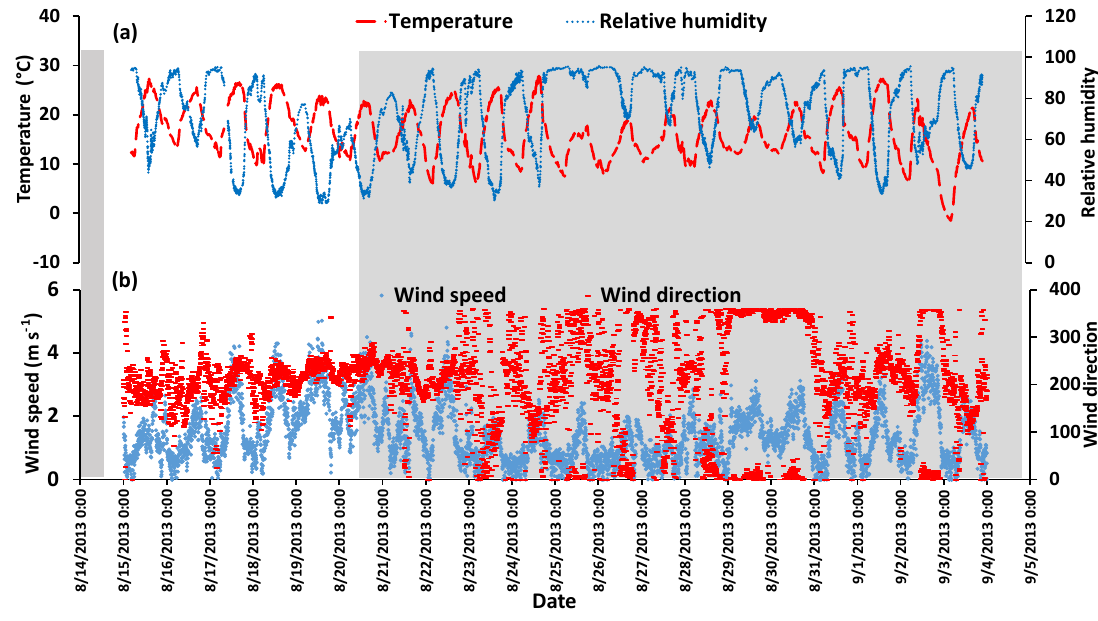
Figure A1. (a) Temperature and relative humidity data with 1min sampling interval. (b) Wind speed and wind direction with the sampling time interval of 5min (data from WBEA meteorological station AMS 13). The gray shaded areas show the CIMS-ON periods.